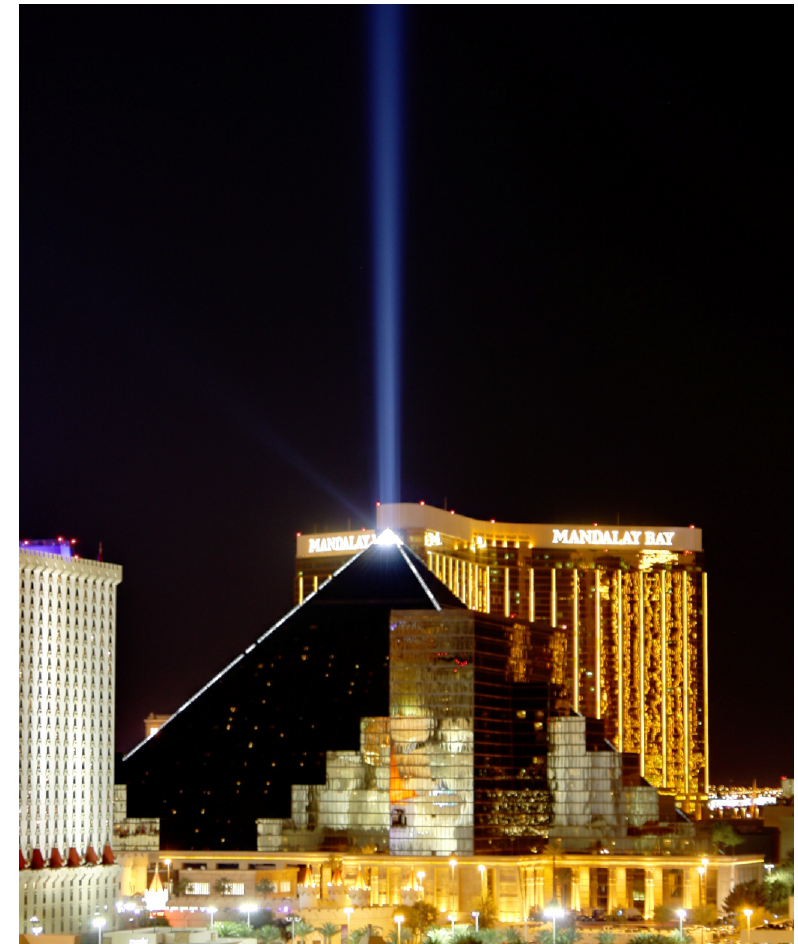
Figure 18. The Luxor sky